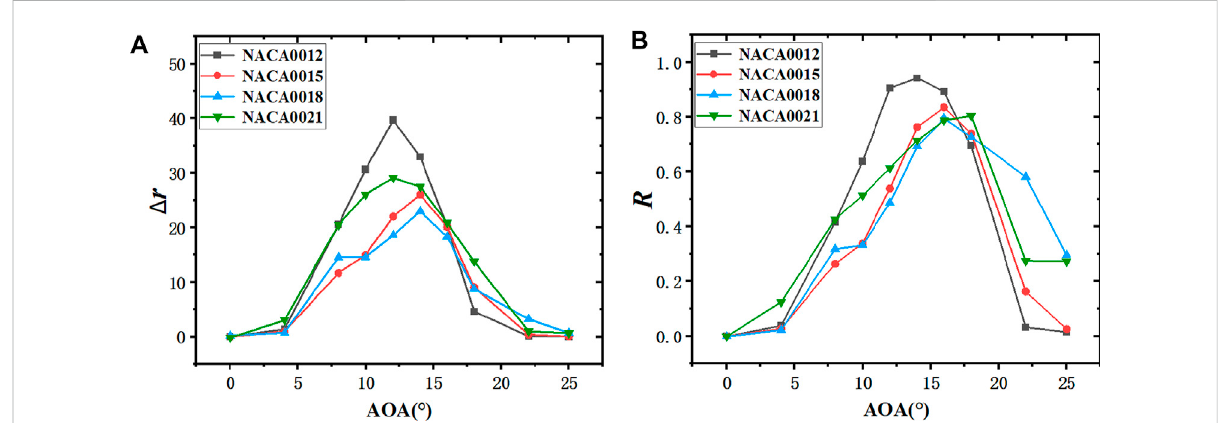
( R (cid:1) r Δ r ; R : Relative difference in the lift-drag ratio; r : Lift-drag ratio of original airfoil; Δ r : Absolute difference in the lift-drag ratio).